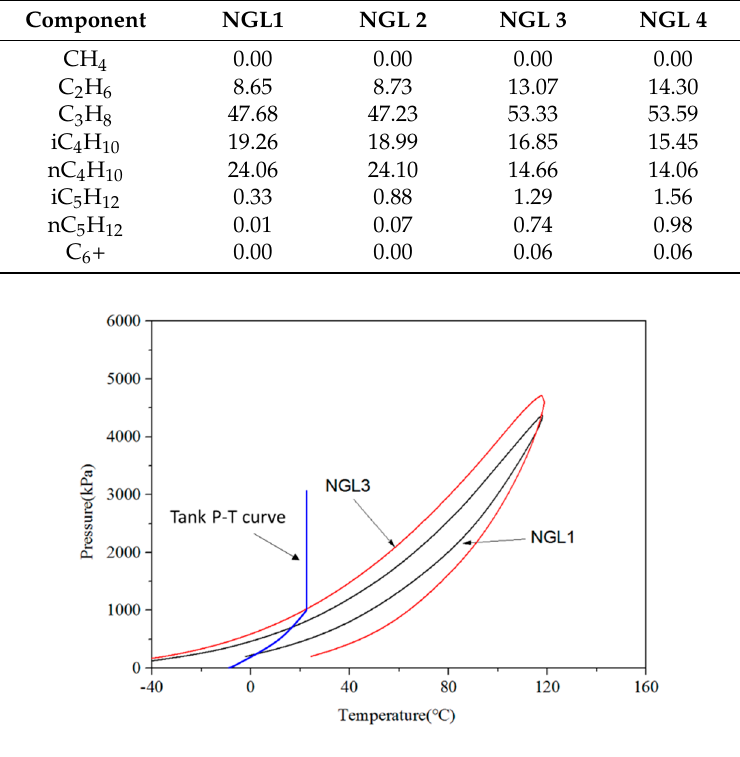
Figure 1. P-T phase curves for NGL components.